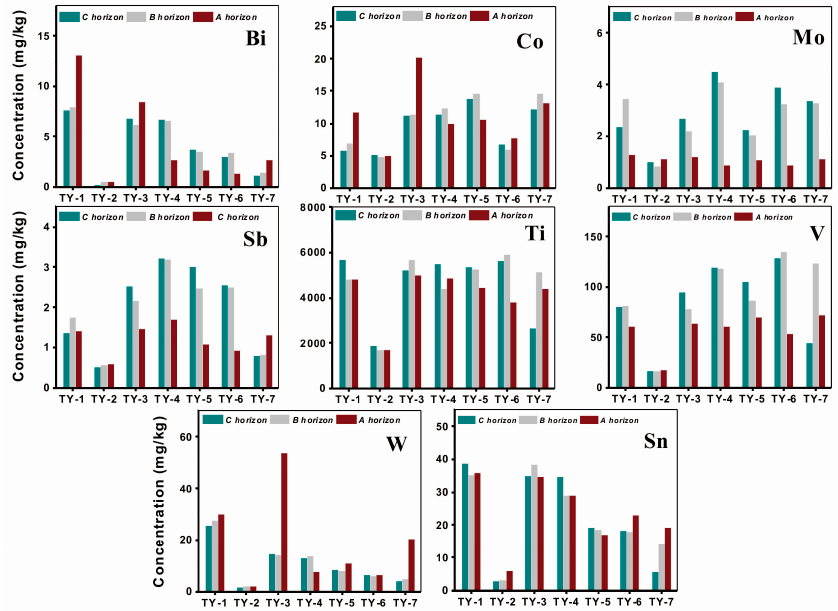
Figure 2. The metal(loid) concentrations in the soils of three different layers.